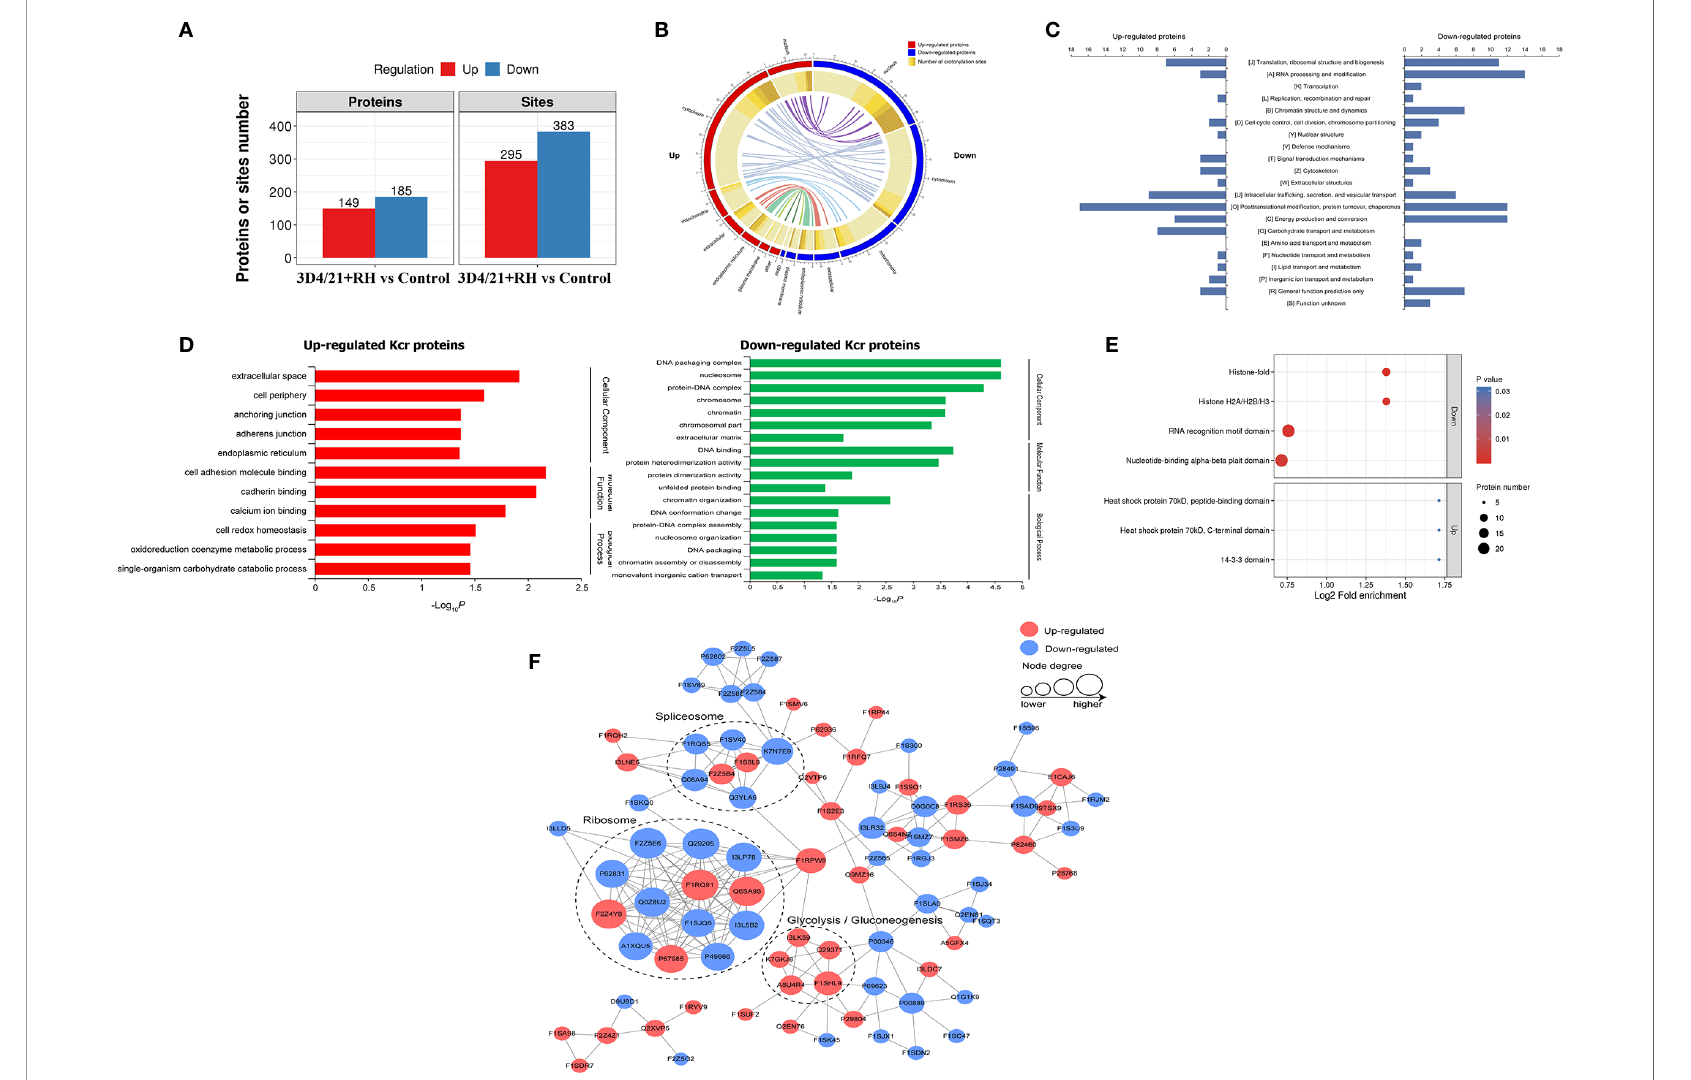
FIGURE 2 | Quantitative analysis of lysine crotonylation in porcine alveolar macrophages after T. gondii infection. (A) The differentially expressed Kcr proteins between 3D4/21+RH and control cells. (B) The differentially crotonylated proteins were classi fi ed based on subcellular location between 3D4/21+RH and control cells. (C) The differentially crotonylated proteins were analyzed by the KOG (Eukaryotic Orthologous Groups) database. (D) Bar graphs showing GO-based enrichment analysis of the differentially crotonylated proteins between 3D4/21+RH and control cells. (E) Bubble diagram showing protein domain enrichment analysis of the differentially crotonylated proteins between 3D4/21+RH and control cells. (F) Interaction networks of all identi fi ed Kcr proteins based on the STRING